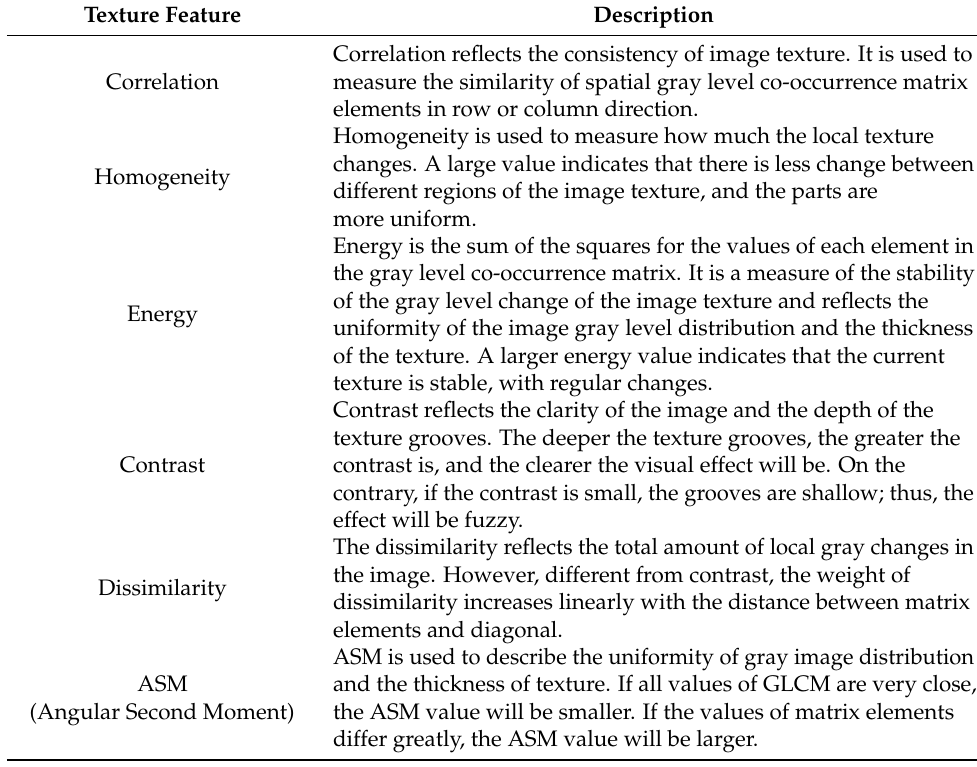
Table 2. Description of the texture